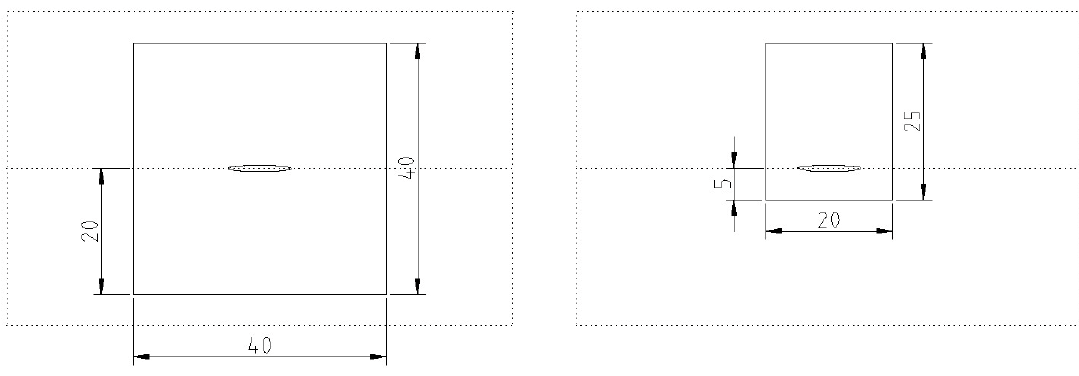
Figure 11. Cross-sections of the specimens for mechanical testing: ( a ) 40 mm × 40 mm with MCF positioned centrally and ( b ) 25 mm × 20 mm with reinforcement positioned in the tension zone.